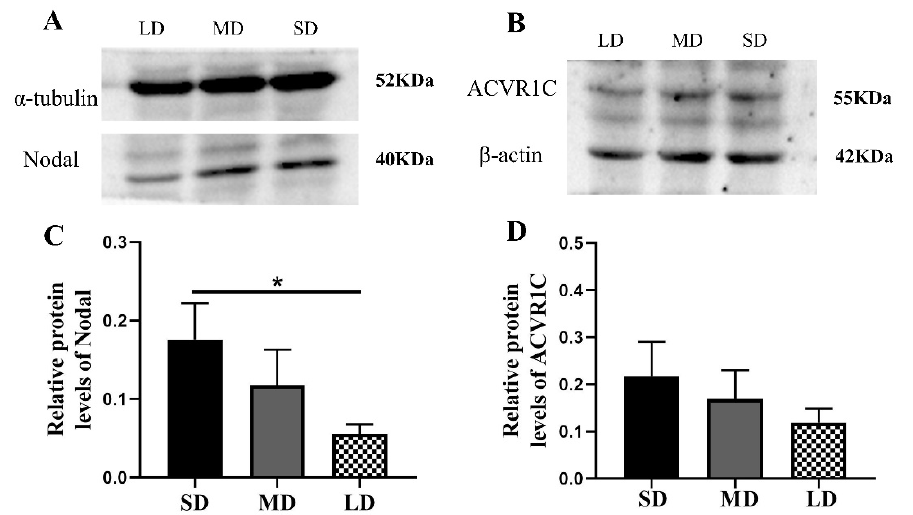
Figure 7. Levels of the Nodal and ACVR1C protein expression in the ovaries of Phodopus sungorus under three photoperiod conditions. ( A , B ) Representative immunoblots of the key Nodal and ACVR1C proteins and internal reference proteins ( α -tubulin and β -actin) in three different photoperiod groups. ( C , D ) Relative protein expression of Nodal and ACVR1C. Values are means ± SEM. n = 8. SD, short daylight; MD, moderate daylight; LD, long daylight. * p < 0.05.